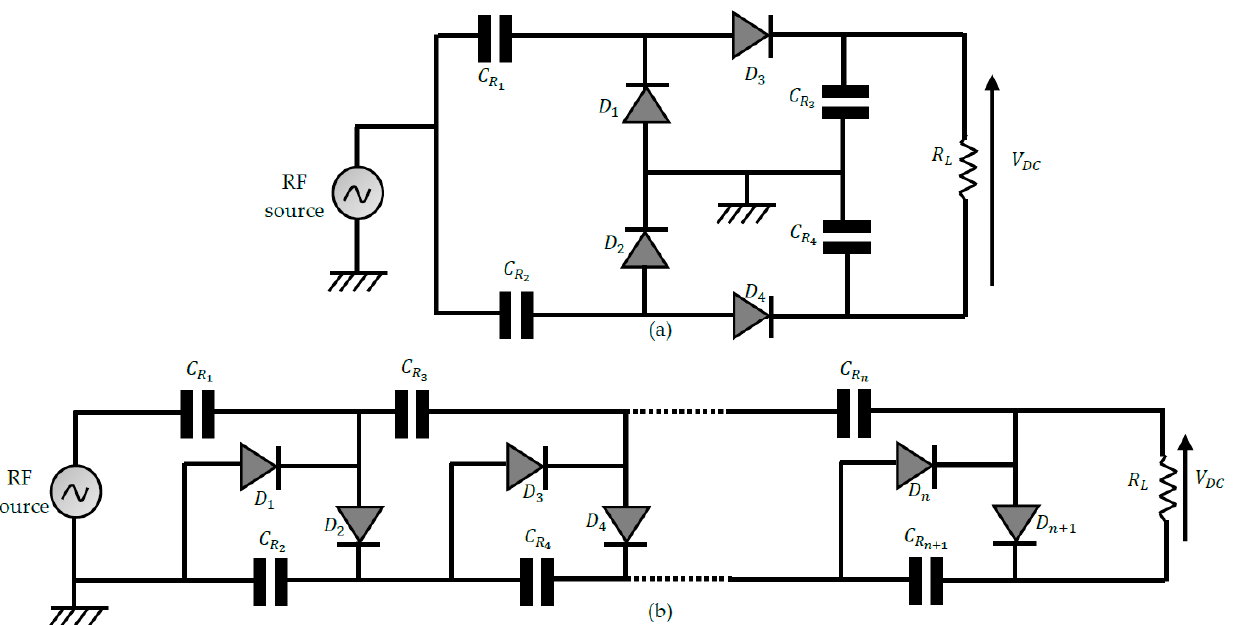
Figure 12. Voltages multiplier topologies. ( a ) Greinacher rectifier configuration. ( b ). Cockcroft-Walton voltage multiplier.